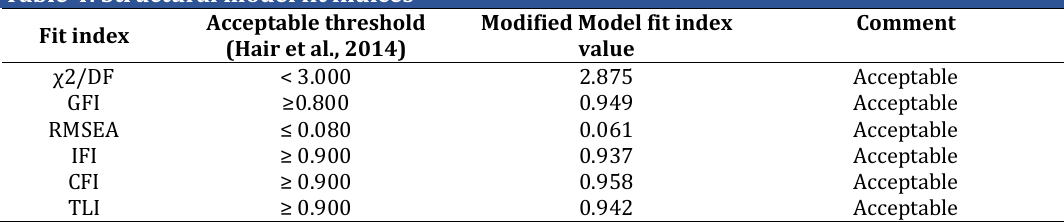
Table 4: Structural model fit indices